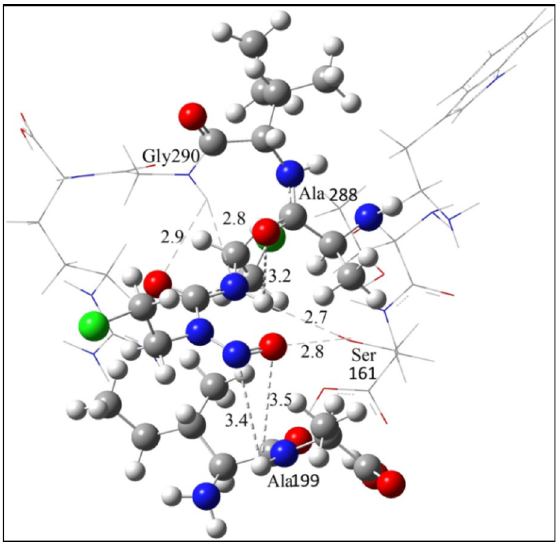
Figure 5. Optimized geometry of carmustine-GR adduct calculated at UM06-2X/6-311G (d,p) UFF level.